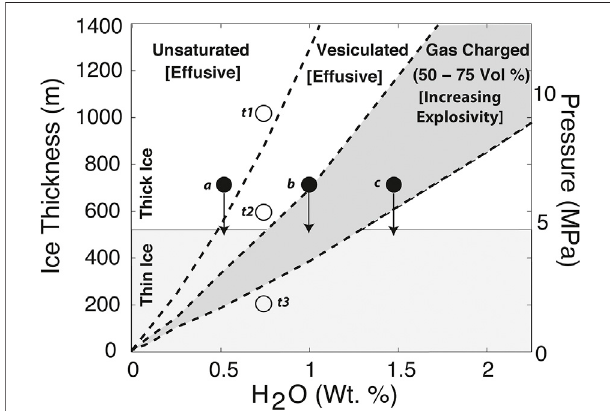
FIGURE 10 | Graph of initial magma water concentrations plotted against Pressure (right axis) and corresponding Ice Thickness (modi fi ed from Edwards et al., 2015). Solid circles (black) with arrows show effects and consequencesresultingfroma2 MPapressuredrop.Opencirclesshow three different possible emplacement pressures for the same